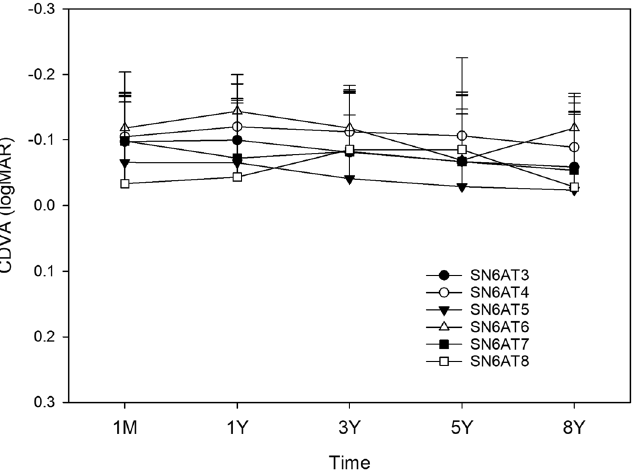
Figure 13. Time course of changes in corrected distance visual acuity (CDVA) by the model of toric IOLs. UDVA was not different among the models ( p > 0.05). logMAR logarithm of minimum angle of